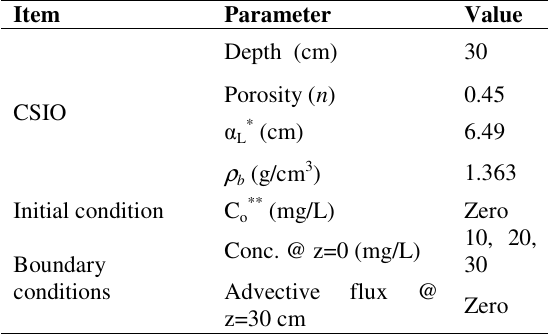
The information utilized in the simulation of contaminant transport in a column packed with